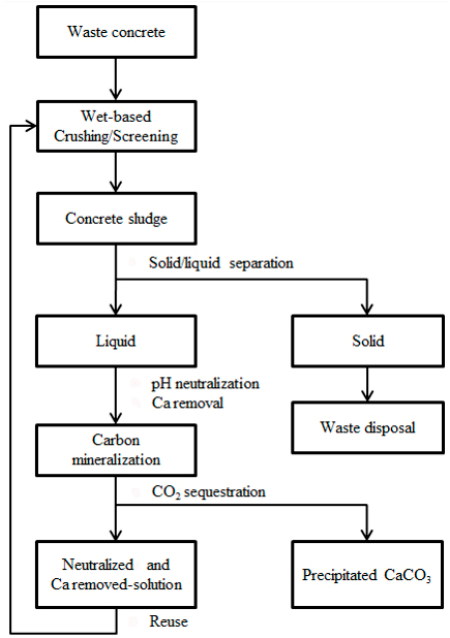
Figure 2. A schematic flow diagram of the neutralization of Ca-rich alkaline wastewater from a waste concrete recycling process by carbon mineralization.